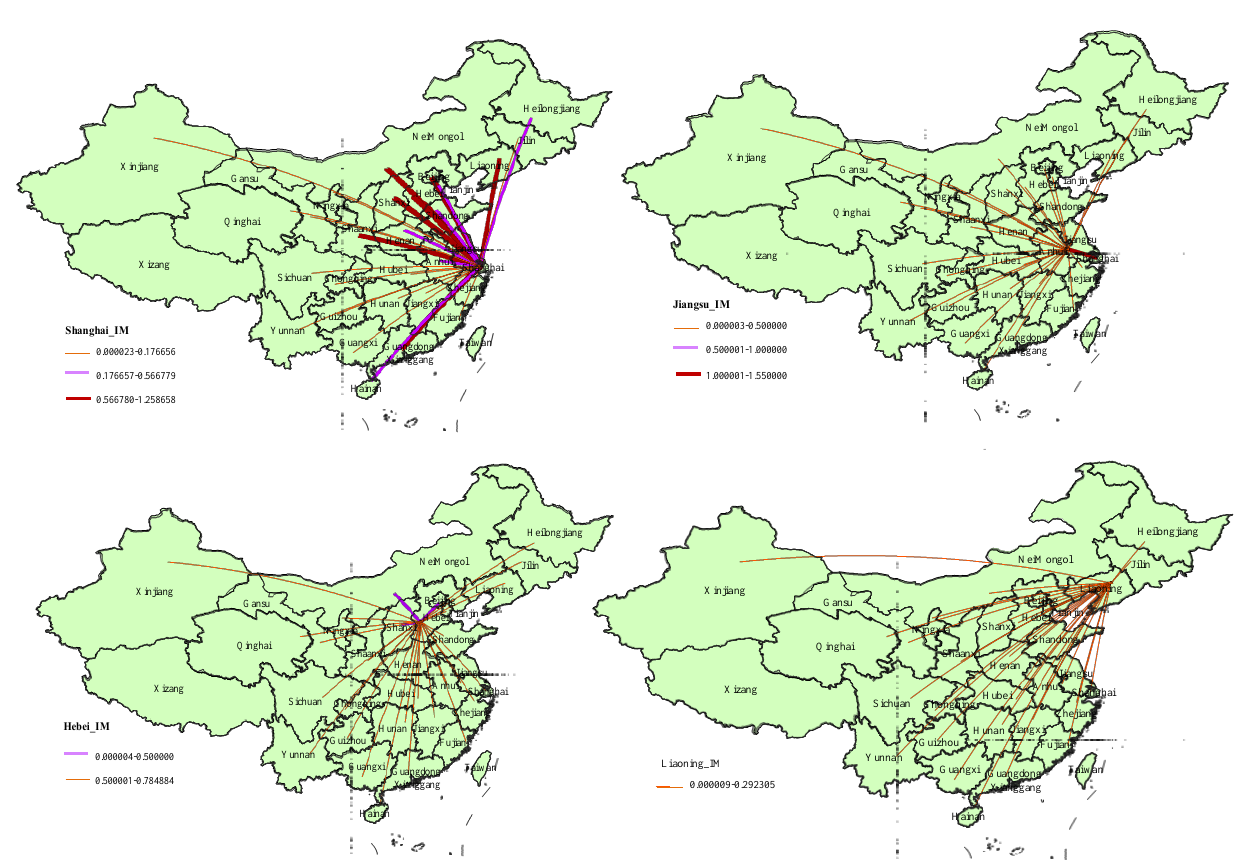
Figure 7. Spatial distribution of energy use embodied in the transport sector imports of the top four provinces in 2012.